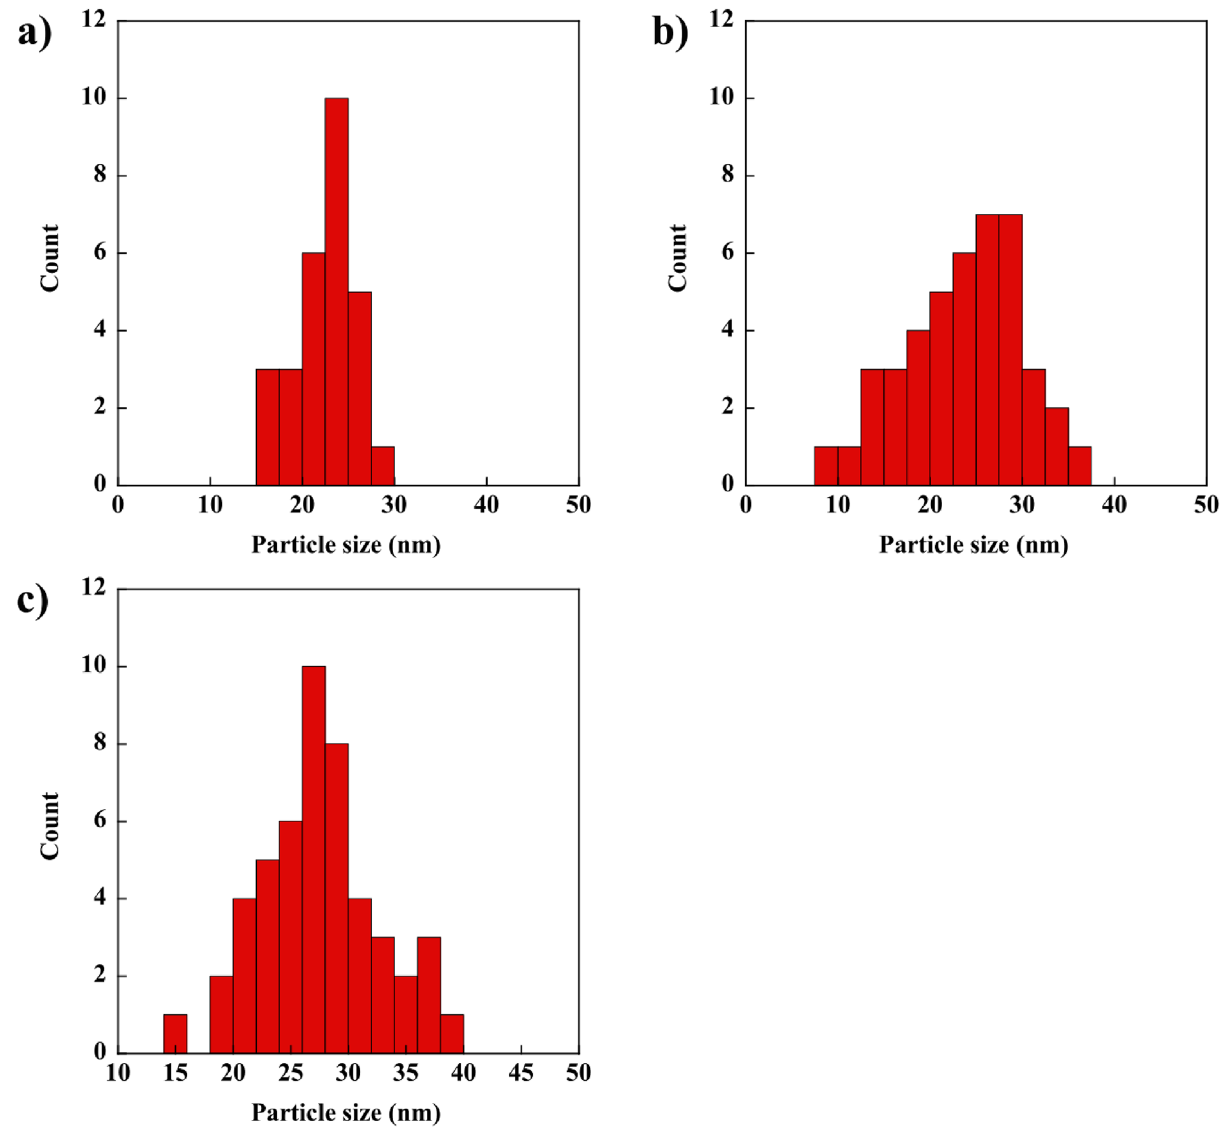
Figure 3. Size distribution of AgNPs at different AgNO 3 concentrations: ( a ) 50 mM, ( b ) 100 mM, and ( c ) 150 (C=C bending), 1635 cm −1 (C=C stretching), 2945 cm −1 (C–H stretching), and 3293 cm −1 (O–H stretching). For